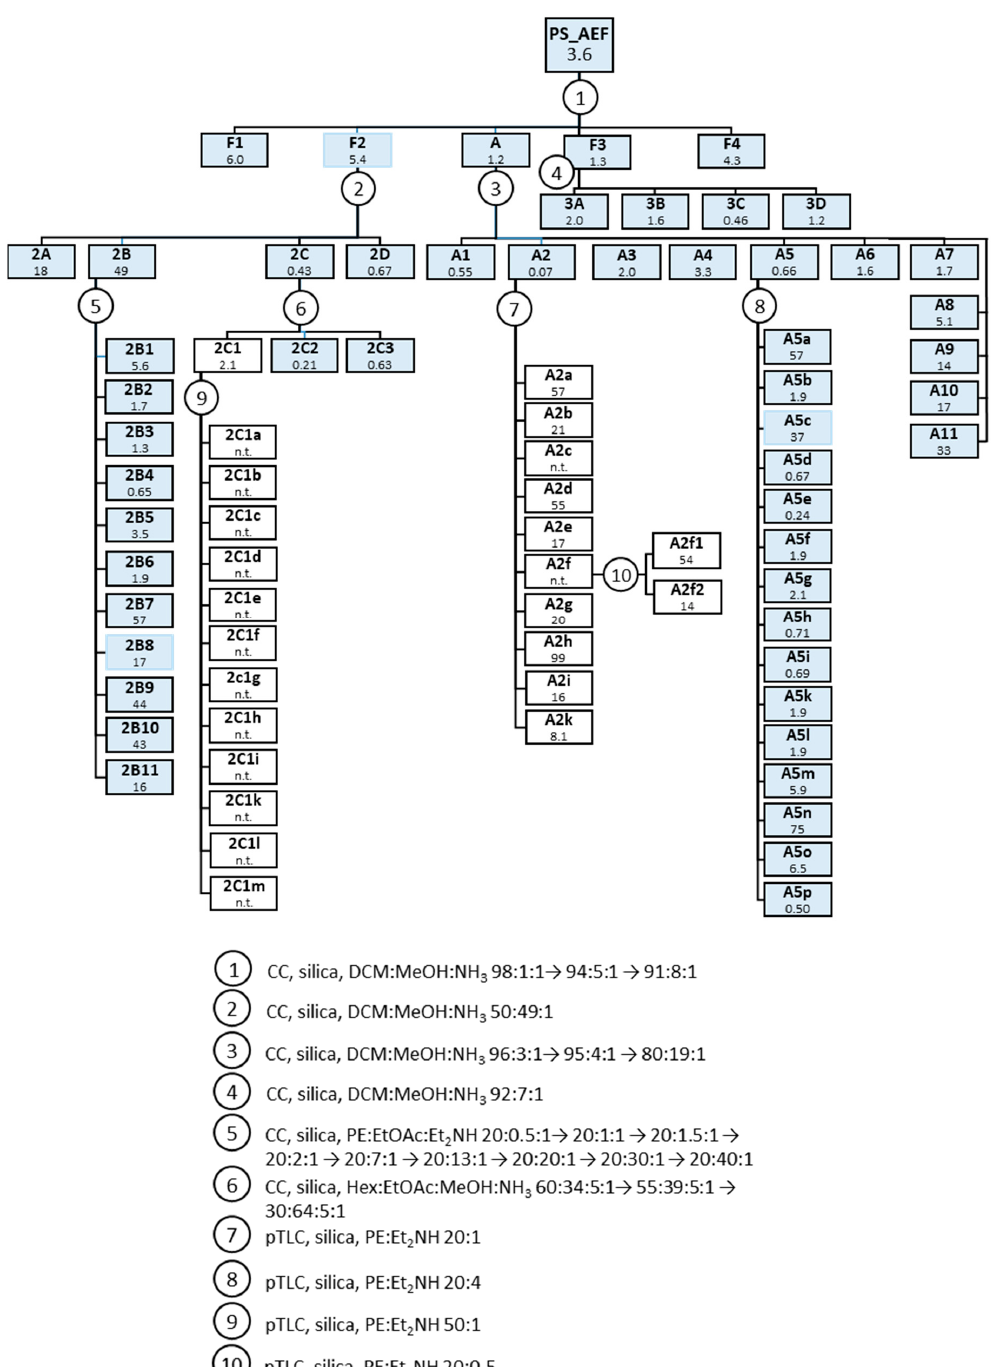
Figure 8. Fractionation of PS_AEF; IC 50 values (µg/mL) of individual fractions against Tbr are reported below the fraction denominations. Fractions in light blue boxes were included in the PLS modeling. Three outliers not included in the final PLS model are marked by light blue frames.